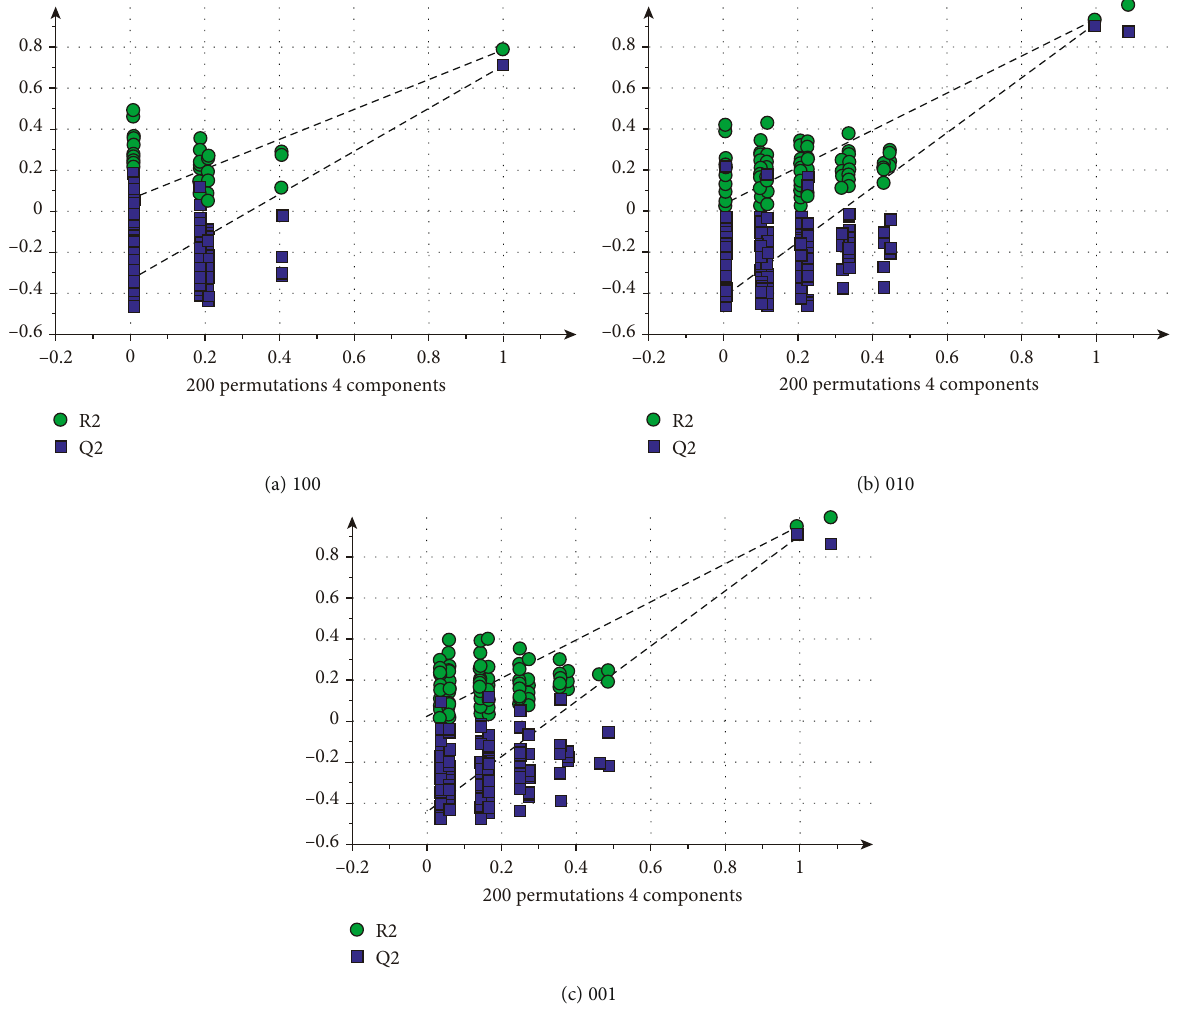
Figure 12: Permutation test validation of the PLS-DA model. 100: fourth aquifer water; 010: coal-bearing sandstone aquifer water; 001: limestone aquifer water. Table 5: Discrimination results of the PLS-DA model for the validation set water